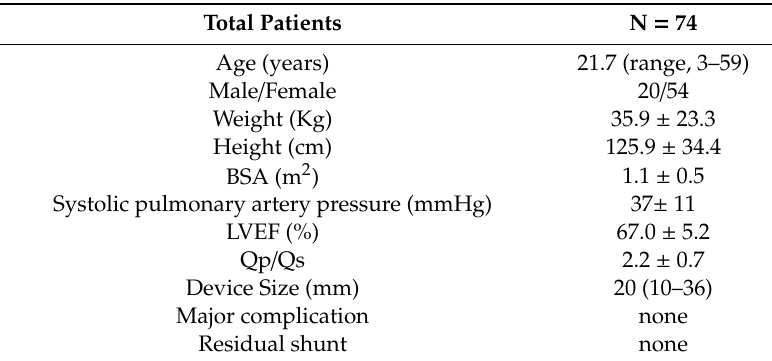
Table 1. Baseline characteristics and hemodynamic